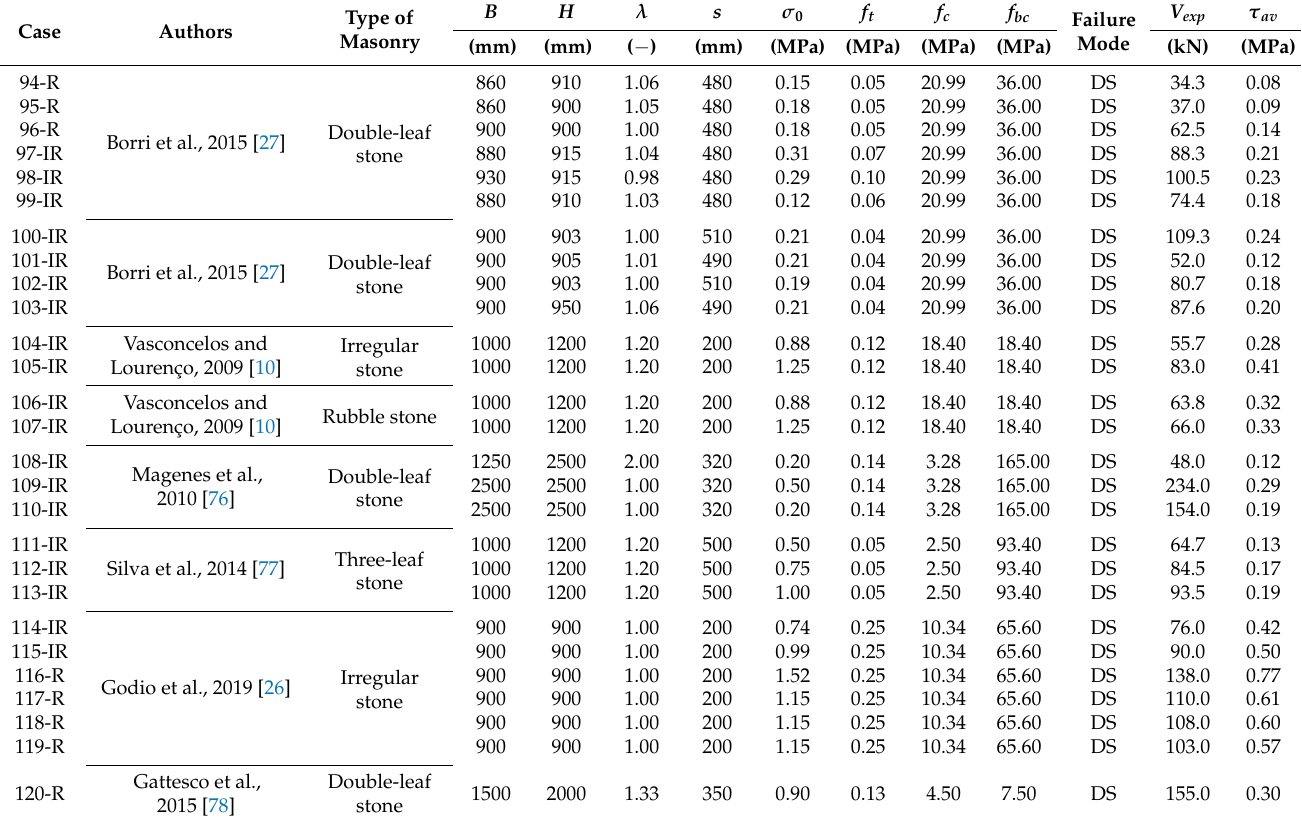
Table 8. Experimental data on irregular/rubble masonry